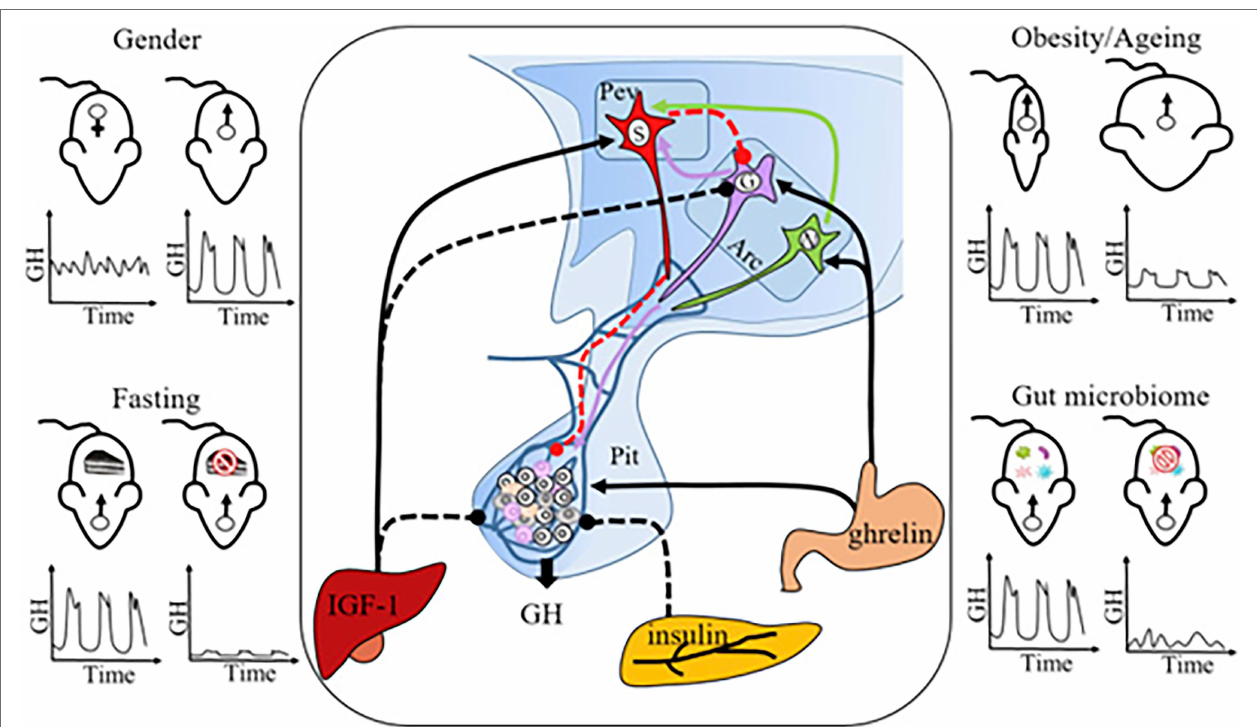
FIGURE 7 | Neuro-Endocrine Mechanisms Regulating Sexually Dimorphic GH Secretion. Pulsatile GH secretion is directly regulated by stimulatory GH-releasing hormone (GHRH), expressed by neurons in the arcuate nucleus (Arc), and inhibitory somatostatin, expressed by neurons in the periventricular nucleus (Pev) of the hypothalamus. GH release is also regulated through feedbacks from peripheral factors, including IGF-1 (inhibitory), insulin (inhibitory), and ghrelin (stimulatory). Sexually dimorphic GH release is the normal physiological pattern ( top left panel ), but some challenges, including fasting ( bottom left panel ), obesity and aging ( top right panel ), and gut microbiome depletion ( bottom right panel ), feminize GH secretion. GH, growth hormone; Pev, periventricular nucleus; Arc, arcuate nucleus; Pit, pituitary gland; S, SRIF (somatotropin release inhibiting factor) neuron; G, GHRH neuron; N, NPY (neuropeptide Y) neuron; and IGF-1 = insulin-like growth factor-1. Solid lines: stimulatory effect; dashed lines: inhibitory effect. Figure used with permission from Huang et al.